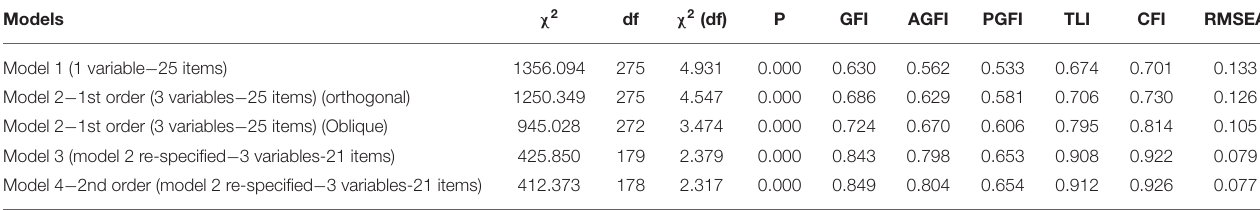
TABLE 2 | Fit índices for image scale.